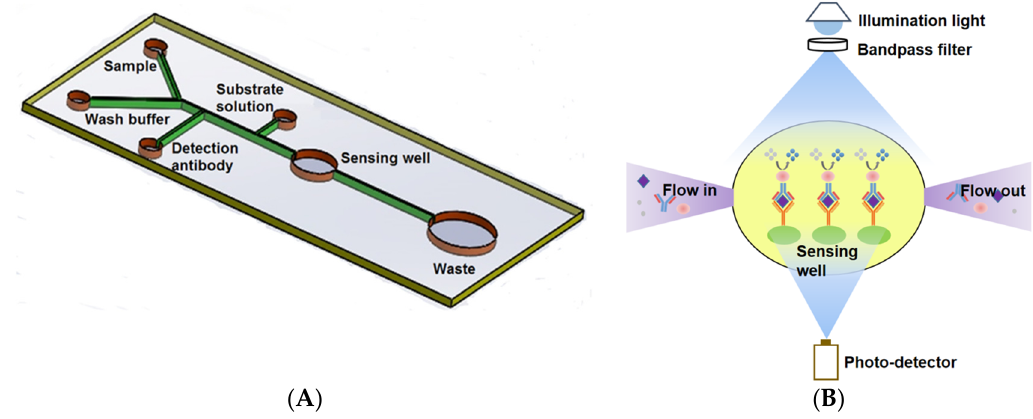
Figure 1. Schematic of the Microfluidic ELISA chip layout (not to scale) ( A ) and Principle of the on-chip absorption detection with the miniaturized optical sensor device ( B ). The diameters of the sensing and waste wells are 2.5 mm and 6 mm, respectively. The width of the main channel and the branch channels are 200 μ m and 100 μ m, respectively. All other wells are 0.75 mm in diameter to fit the loading syringe tip.